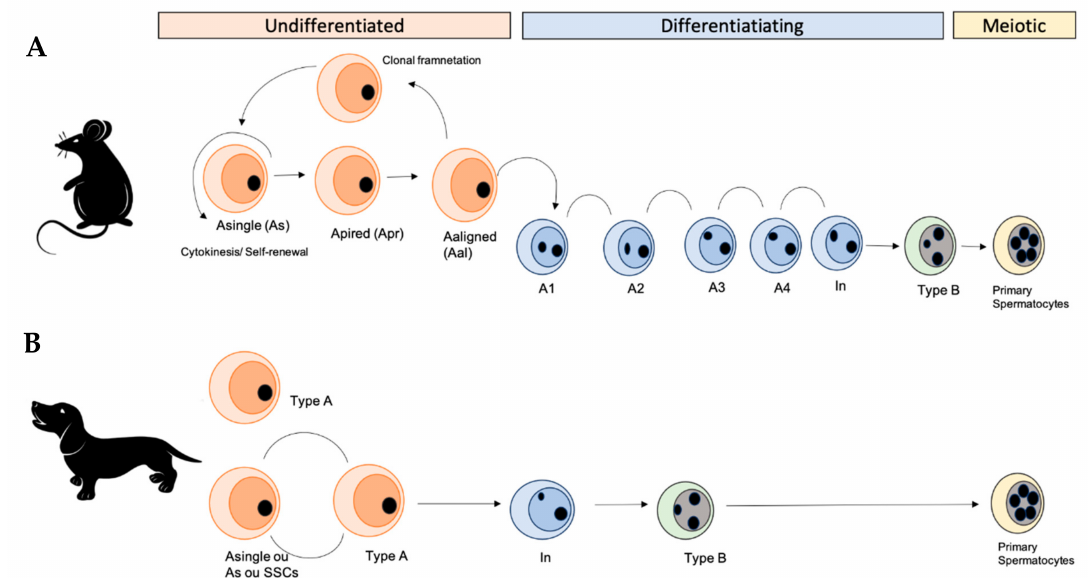
Figure 2. Self-renewal and differentiation of the spermatogonial population of rodents and canine. ( A ) Spermatogonial stages in rodents, showing the different subtypes of spermatogonia. Spermatogonial stem cells or Asingle spermatogonia (As) are rare cells in the testes and they can self-renew to produce two new As (self-renewing division) or for mitotic division, differentiate into spermatogonia Apaired (Apr). In addition, spermatogonia Apr remain connected by a bridge intercellularly and in the next mitotic division produce a chain of four Aaligned spermatogonia (Aal4). These As, Apr, and Aal form the population of undifferentiated spermatogonia in the seminiferous tubules. The Aal spermatogonia could undergo one or more mitotic divisions to form chains of 8, 16, and sometimes 32 cells. The last phase of this process occurs during the differentiation of spermatogonia A1. After, A1 spermatogonia undergo sequential mitotic division and produce types A2, A3, A4, Intermediate, and B spermatogonia, which divide to produce primary spermatocytes. ( B ) In canine, spermatogonia type A are stem cells (SSCs or As) that self-renew and proliferate, resulting in mitosis and differentiation into intermediate and later type B, which divide to generate primary spermatocytes (Based on the data described